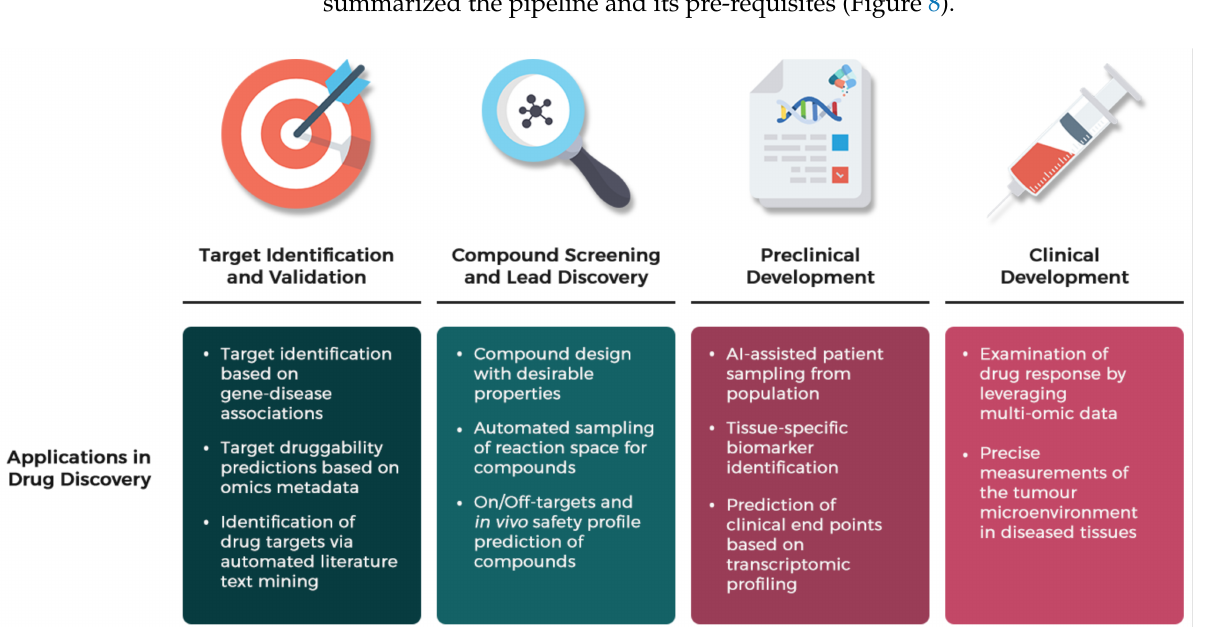
Figure 8. Machine learning applications in the drug discovery pipeline. Promising developments of pioneering ML research has brought forth unprecedented advances across various stages of the traditional drug development pipeline, especially the concept of automation in the early drug discovery process of target identification and validation & compound screening and lead discovery; relying on the domain of NLP in AI to find prospective drug targets by scanning upon thousands of relevant literature based on contextual information in research papers, and integrating AI with synthesis robots to explore unknown reaction space to search for drug candidates in which multiple chemical experiments are conducted automatically in real-time to assess the reproducibility of chemical reactions and discover new reaction outcomes. AI in the preclinical development has been a game-changer for patient selection in Phase II and III clinical trials by identifying and predicting human-relevant biomarkers of diseases, thus preventing unnecessary toxicities and side effects of consuming the experimental drugs for the designated patients